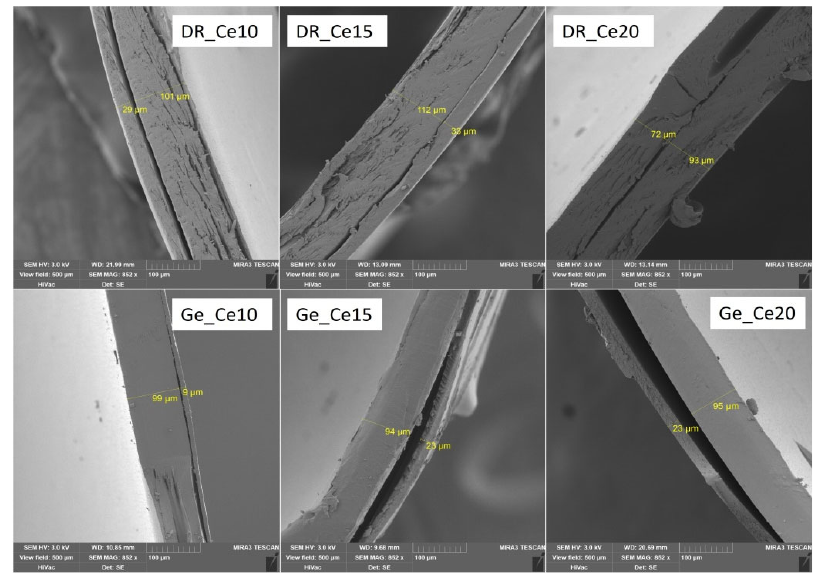
Figure 2. SEM images of selected samples with Cellacefate coating on both types of capsules.